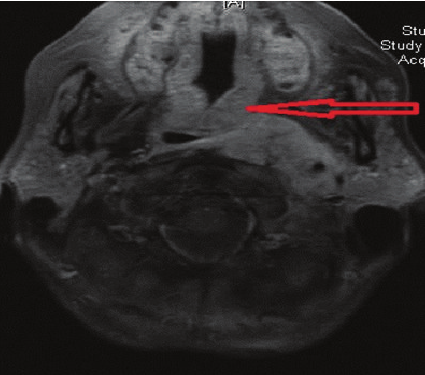
Figure 1: MRI of neck showing pharyngeal mass.